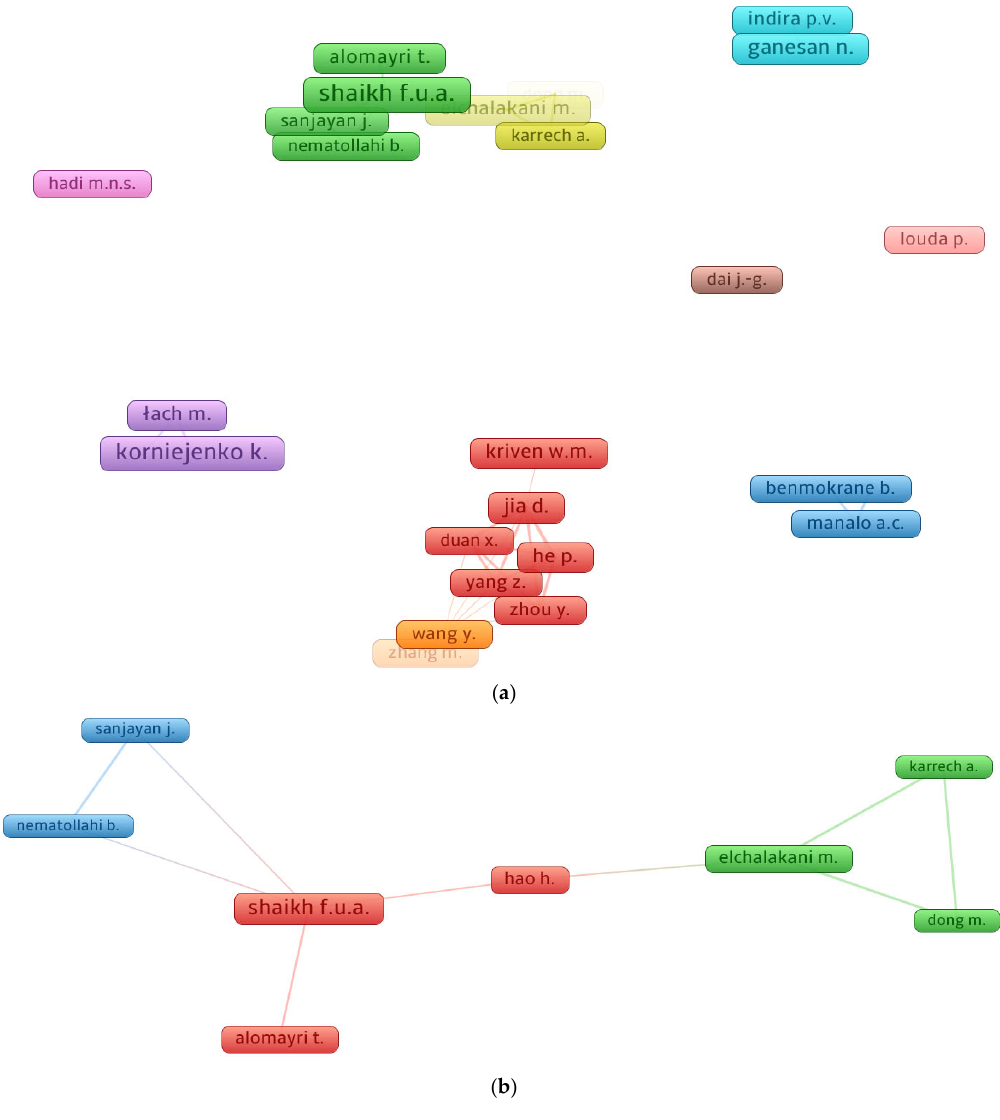
Figure 7. Systematic map indicating author’s collaborations: ( a ) authors with at least 10 articles; ( b ) connected authors based on citations. Table 4. List of documents having most citations received up to June